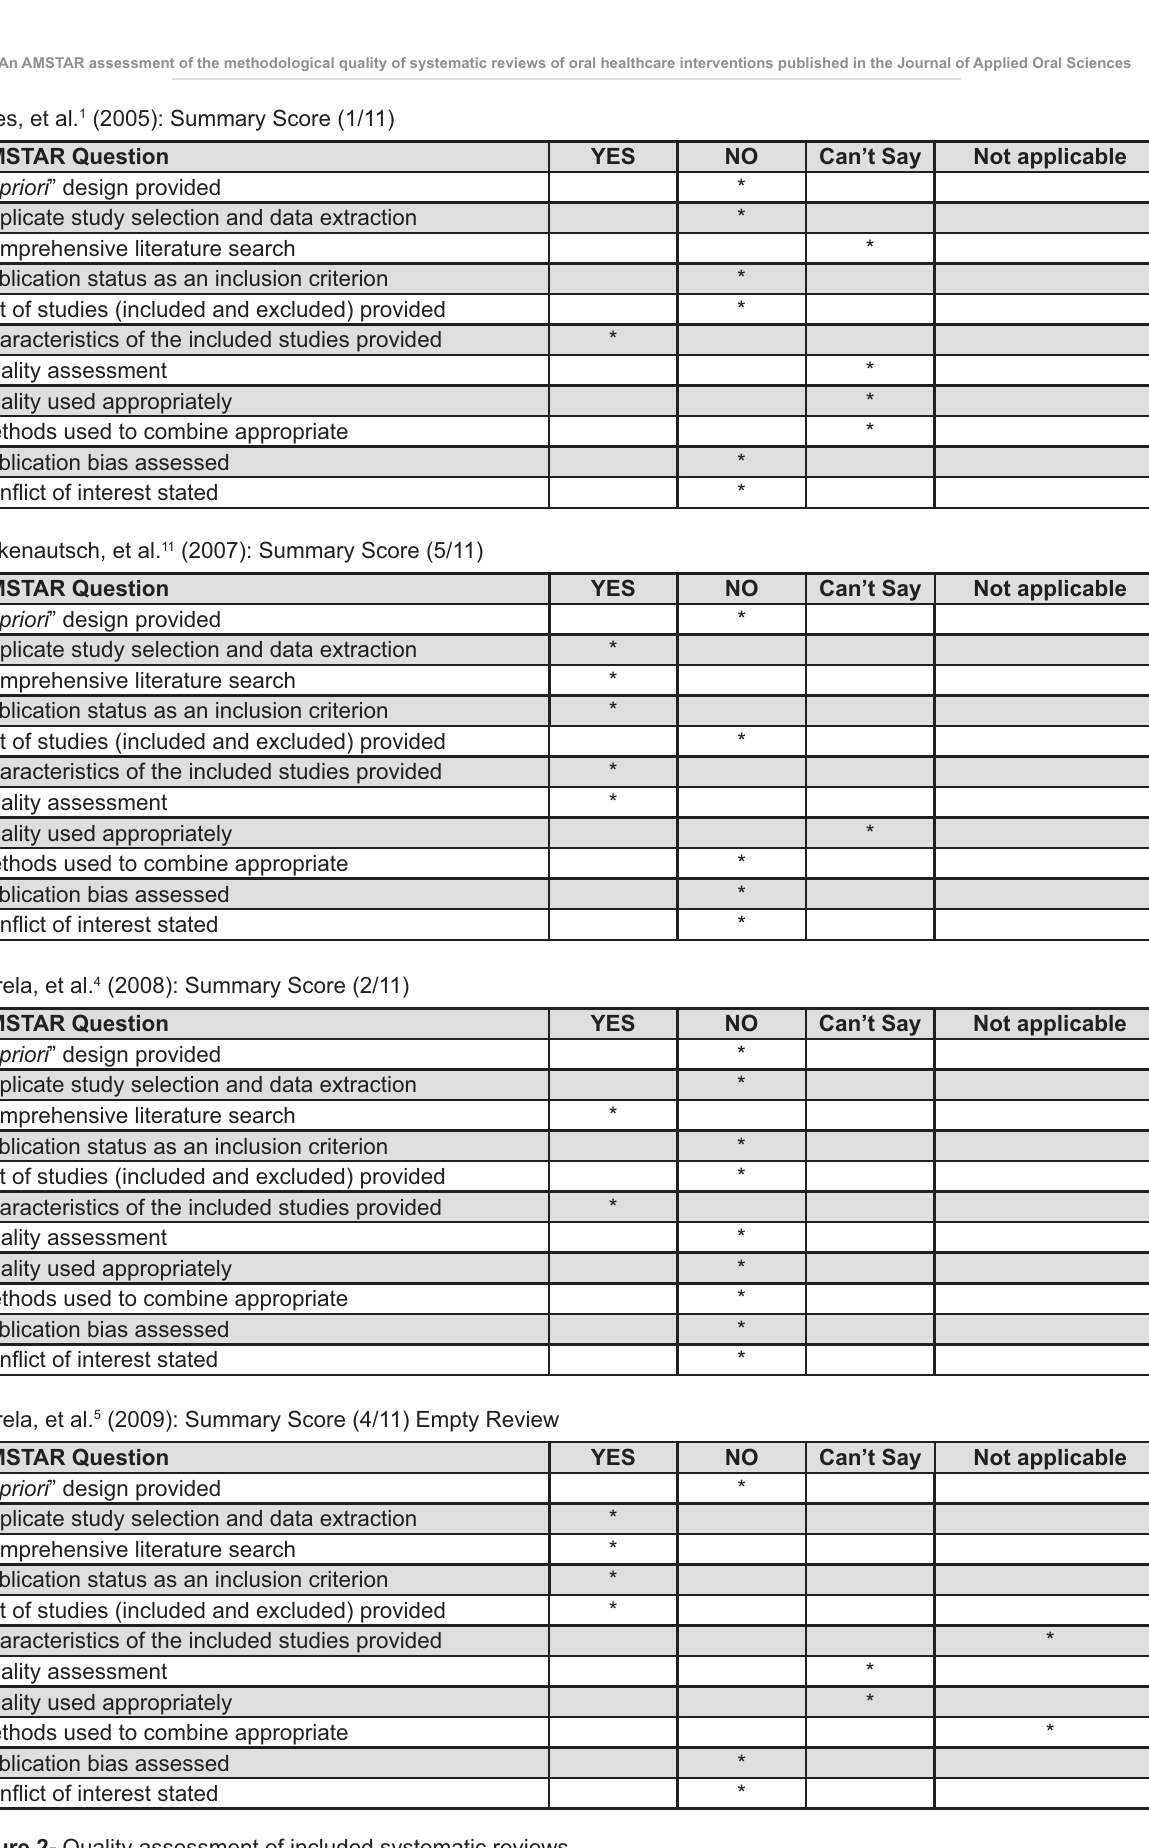
Figure 2- Quality assessment of included systematic